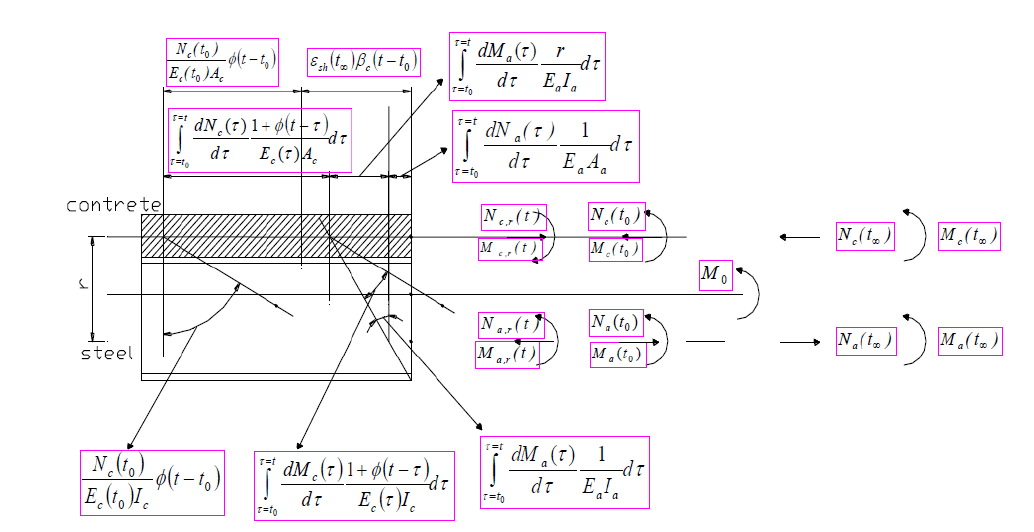
Figure 1. Mechano-Mathematical model for deformations in cross-section in composite steel-concrete beam, regarding creep of the